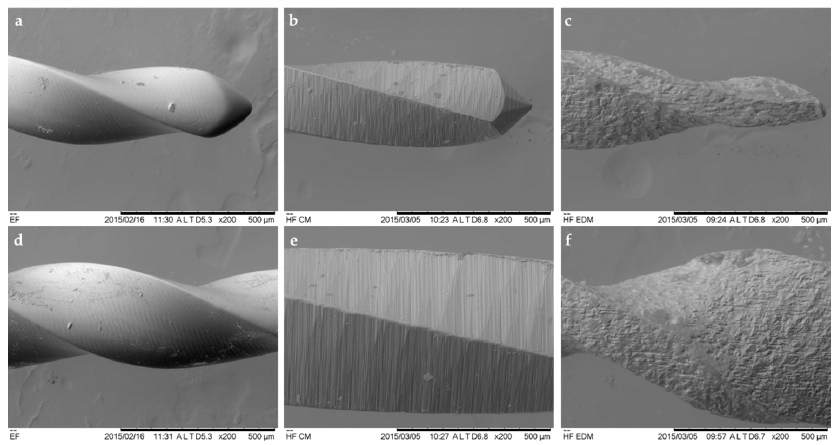
Figure 4. Micrographs of new thermally treated EF ( a , d ), CM ( b , e ) and EDM ( c , f ) endodontic instruments, demonstrating significant topographic differences of the surfaces (magnification ×200).